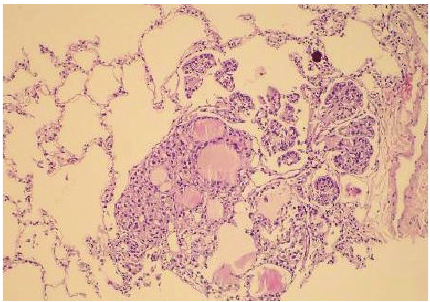
Figure 3: A focus of thyroid papillary carcinoma is seen while penetrating into an alveolar lumen near the arteriole. In the focus of the metastasis, the follicular and papillary structures presenting with colloid in their lumens aredisplayed along with thepsammoma body (H&E × 100).